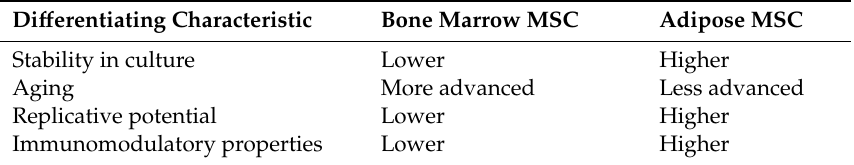
Table 1. Di ff erences in the properties of bone marrow and fat mesenchymal stem